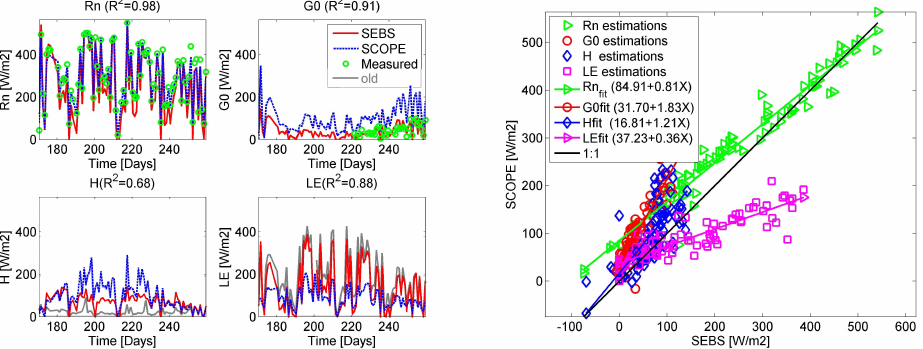
Fig. 6. Comparison of instantaneous surface heat fluxes predicted by SEBS and SCOPE. In the left panel the diurnal measurements and estimations are shown. There were no measurements of sensible heat and latent heat over the thinned maize field. In the right panel a scatterplot between SEBS and SCOPE estimated heat fluxes is shown. The instantaneous surface heat fluxes from SEBS show a high correlation with the SCOPE estimated surface heat fluxes. SEBS underestimates the sensible heat flux for a fully developed maize canopy (between day 200 and 220).